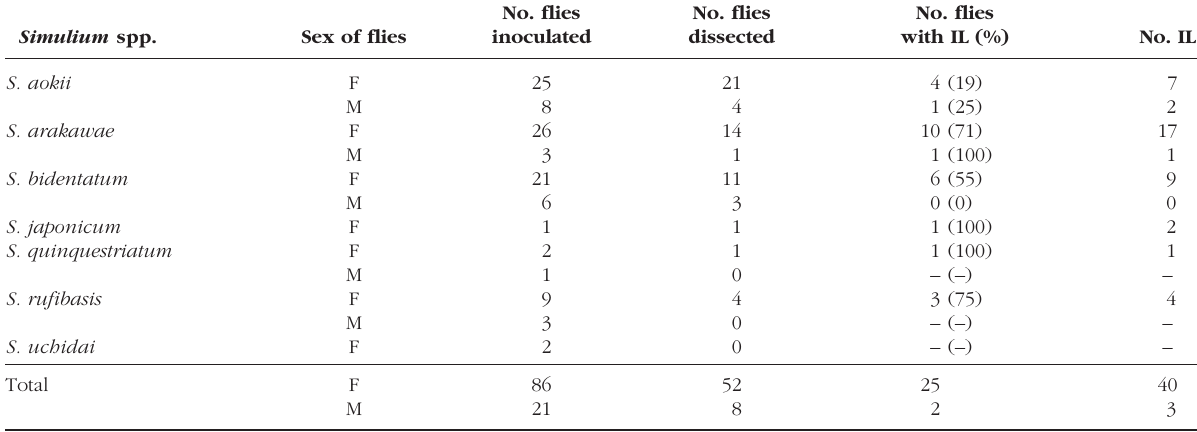
Table I. – Results of experimental infections of Simulium species with Onchocerca dewittei japonica .